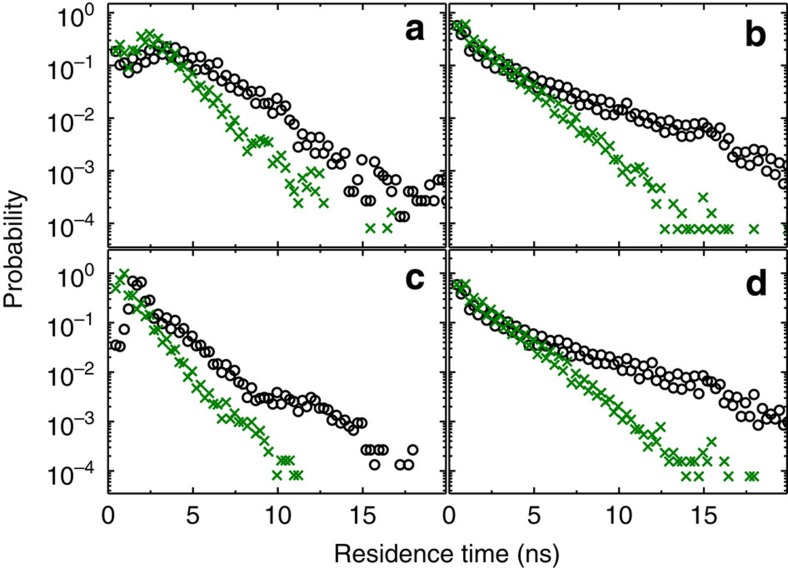
Residence-time distributions.Numerical, (a,c), and experimental, (b,d), residence-time distributions in the states corresponding to the two delays of τ1=106.075 ns and τ2=121.625 ns. Dots correspond to 1.0Ith and crosses to 1.1Ith. (a, b) show the residence times in filter state 1 while (c,d) correspond to filter state 2.